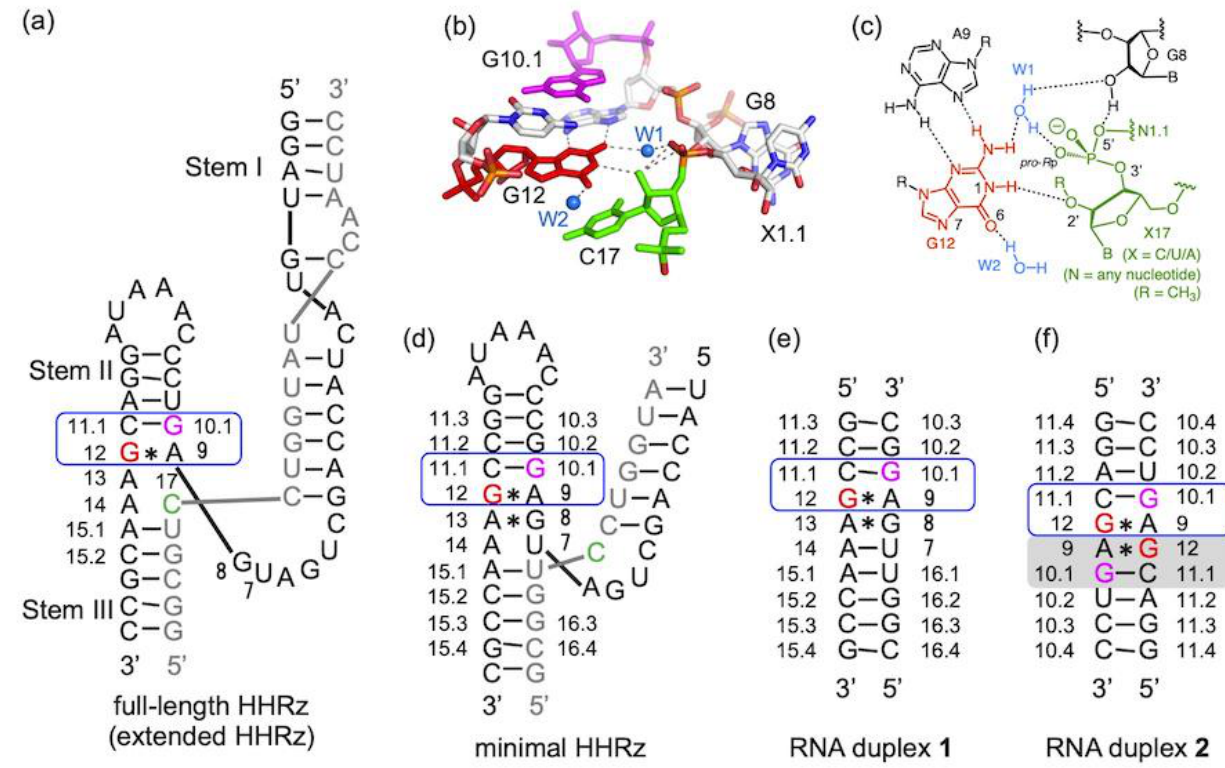
Figure 1. Summary of hammerhead ribozyme (HHRz). ( a ) Secondary structure and sequence of full- length HHRz (extended HHRz) from Schistosoma mansoni. ( b ) Crystal structure (PDB ID: 2OEU [21]) of the catalytic unit (metal ion-binding motif), which would activate the deprotonation of 2′ -OH(C17) (X = C in Schistosoma mansoni). Names of the catalytically important residues are shown in the panel, and hydrogen bonds are depicted as broken lines. Methyl groups on the O 2′ (C17) are omitted for clarity, and the broken lines between O 2′ (C17) and pro-R P / pro-S P oxygen atoms represent the putative hydrogen bonds for the native 2′ -OH form. W1 and W2 are the crystallographically observed water molecules. ( c ) Schematic representation of catalytically important residues and their most probable interactions. ( d ) Secondary structure and sequence of minimal HHRz. ( e ) Sequence of model RNA duplex 1 . ( f ) Sequence of model RNA duplex 2 . In all panels, G12/G12-corresponding (G12*) residue, G10.1/G10.1-corresponding (G10.1*) residue and C17 residue are colored in red, ma- genta and green, respectively. In ( a ), ( d – f ), each metal ion-binding motif (A9-G10.1 motif) is sur- rounded by a blue box. In ( f ), the second A9-G10.1 motif in RNA duplex 2 is highlighted by a gray background. In the main text, residue numbers of HHRzs are applied to relevant residue in the model RNA duplexes with asterisk (*).